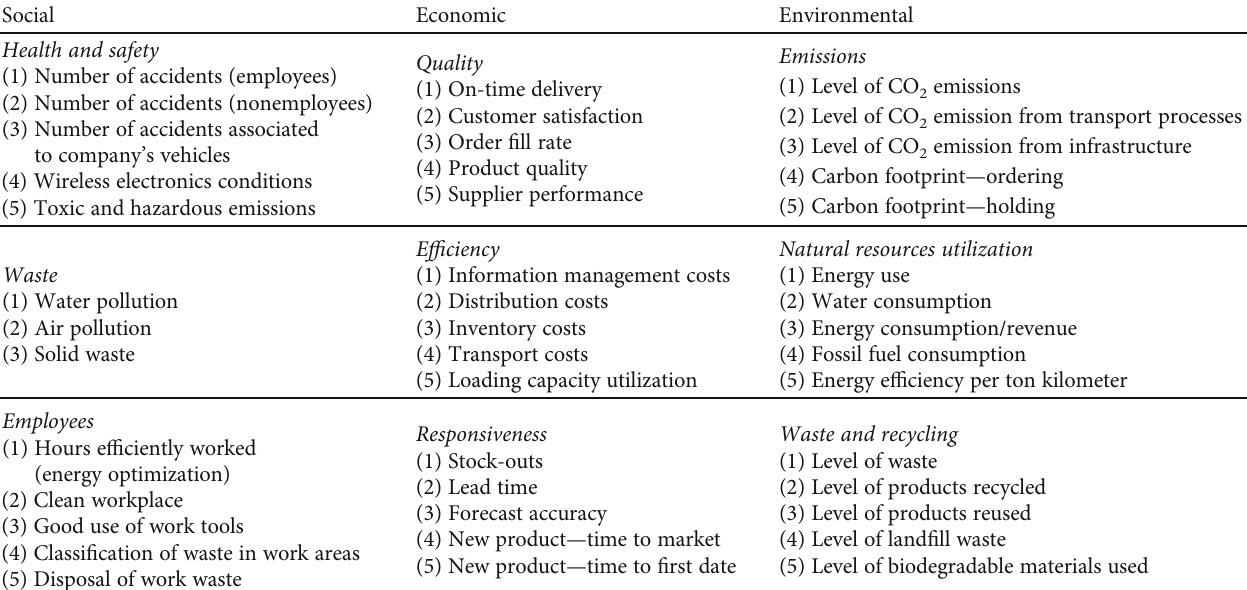
Table 3: Supply chain metrics: performance indicators on sustainability (own